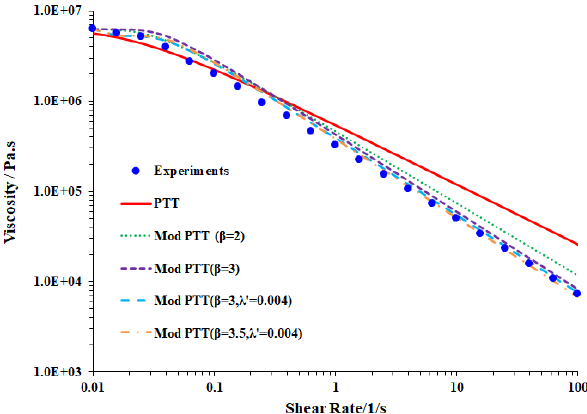
Figure 5: Viscosity as a function of shear rate for different β with T = 120 ∘ C, α = 12.3 , λ = 4.7 s and η = 6.2 E + 6 Pa · s Figure 6: Viscosity as a function of shear rate for different β and λ ′ with T = 120 ∘ C, α = 12.3 , λ = 4.7 s and η = 6 .2E + 6 Pa · s